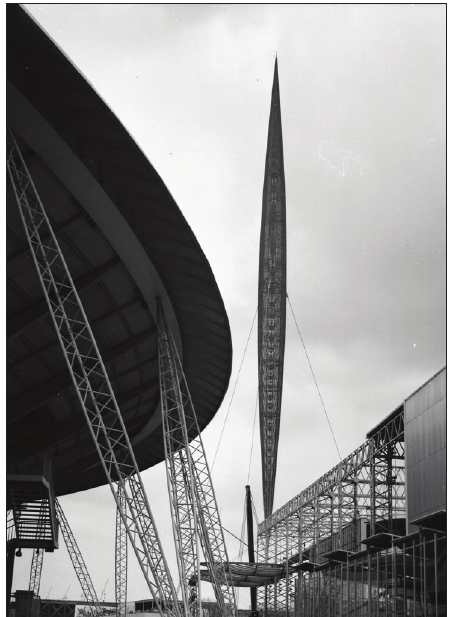
Figure 1: The Skylon at the Festival of Britain, 1951. (Image uploaded by Heresy0uk – Photo taken by Bernard William Lee, CC BY-SA 4.0, https://commons.wikimedia.